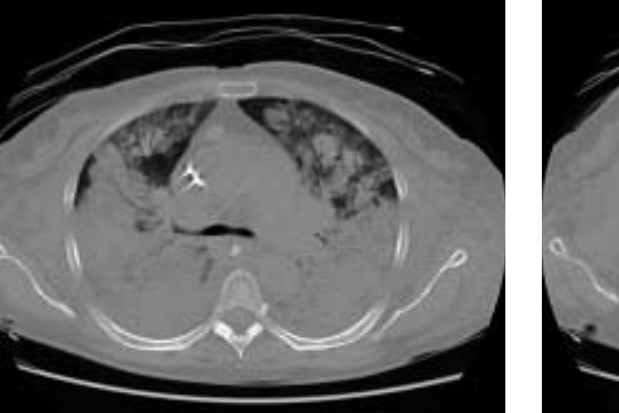
Figure 2 An example of an ARDS patient with high potential for recruitment. a: PEEP of 5 cm H 2 O; b: end